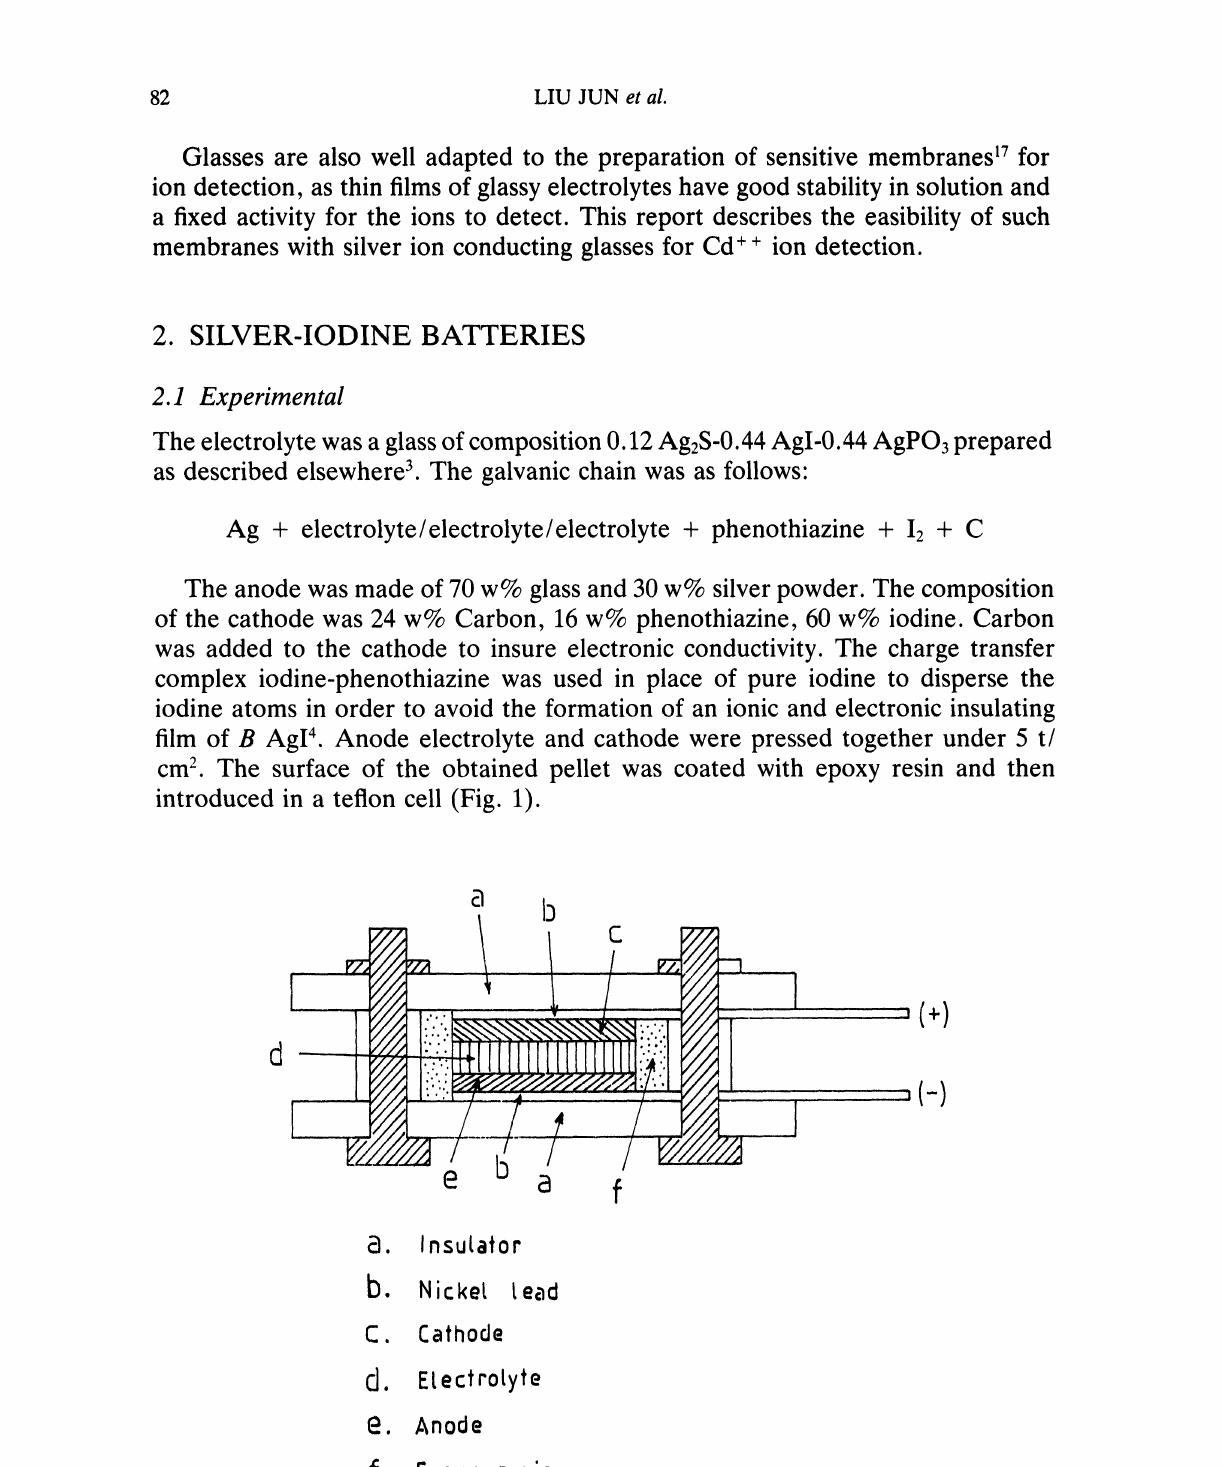
Insutaor Nicker read F.alhode Etectrotyte Anode Epoxy resin FIGURE Cross section of the battery test